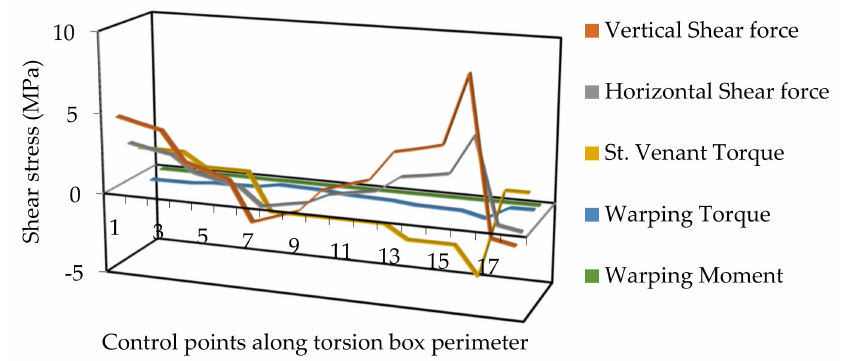
Figure 14. Evolution of the shear and normal stresses along control points that define torsion box perimeter in the initial condition ( y = 14.225 m and z = 14.82 m).